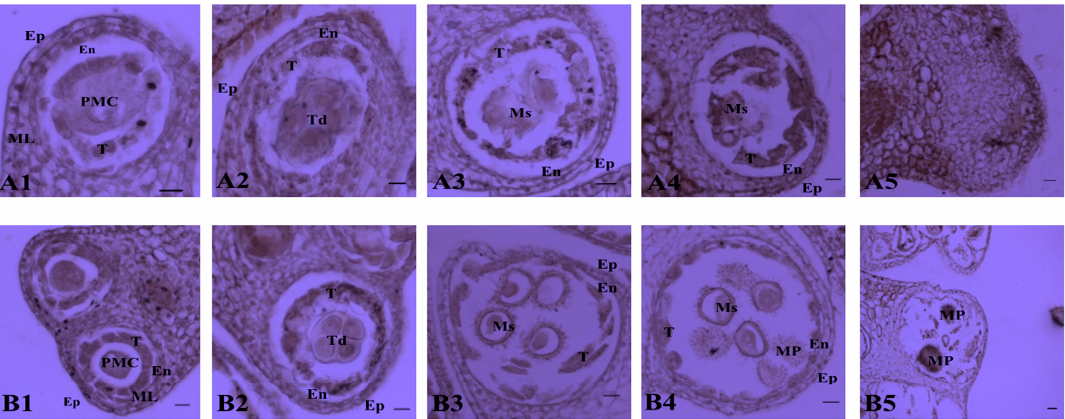
Figure 2. Comparative analysis of anther development between H276A ( A1 – A5 ) and H276B ( B1 – B5 ). Notes: Bar = 50 μ m for all of the stage. PMC, pollen mother cell; Ep, epidermis; En, endothecium; ML, middle layer; T, tapetum; Ms, microspore; MP, mature pollen.